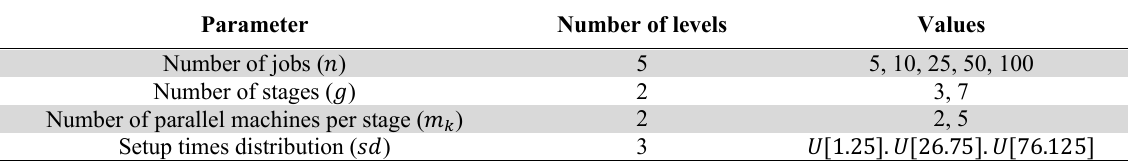
Parameters used in the testbed